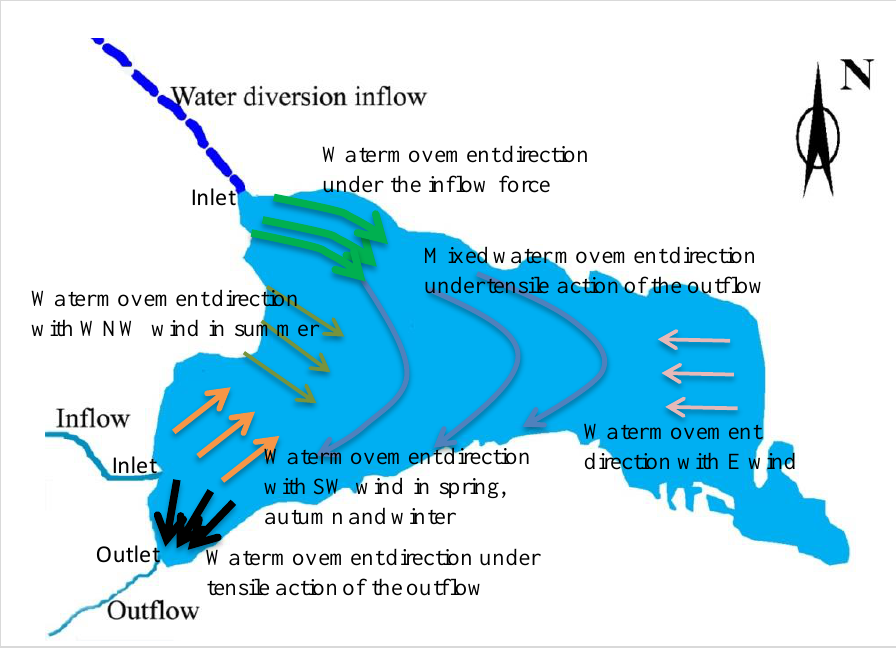
Figure 12. Water movement and water exchange after water diversion in Bosten Lake.